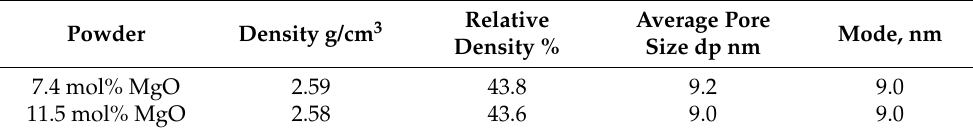
Table 2. Compact characteristics.